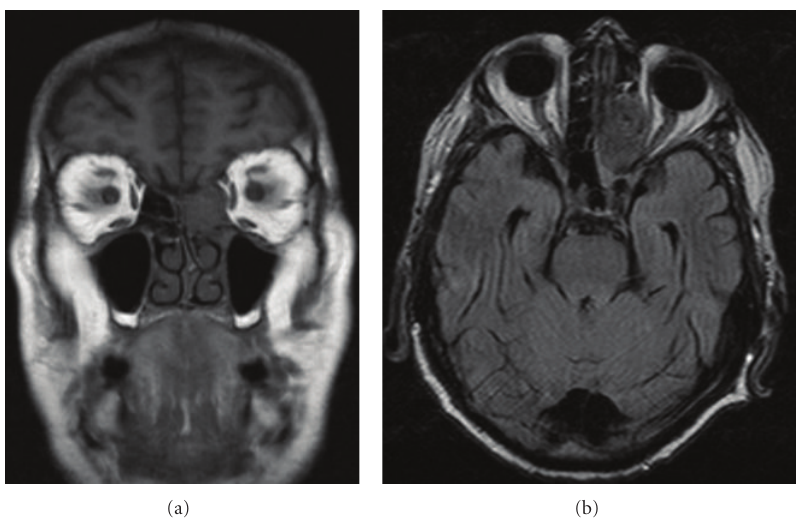
Figure 2: MRI scan shows an abnormal soft tissue lesion within the left paranasal sinuses centered on the ethmoid air cells. Note the distortion of the medial wall of the orbit and narrowing of the orbital apex causing distortion and compression of the left optic